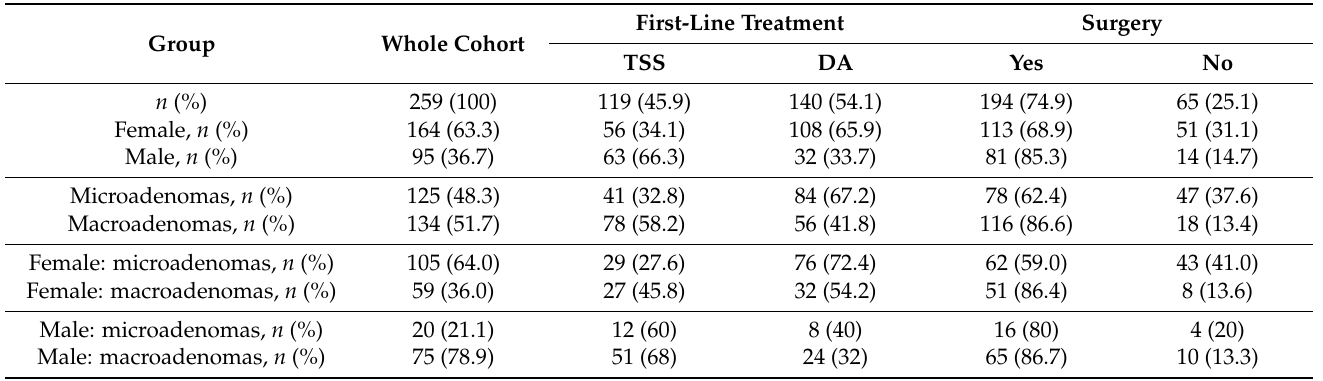
Table 1. Baseline characteristics of the study patients and first-line